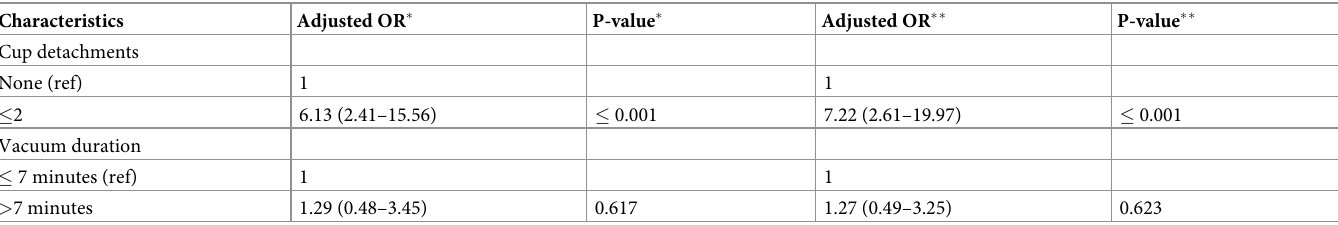
Table 3. Multivariable linear regression analysis for attempted midpelvic vacuum extractions (n = 319) with odds ratio indicating the risk of failure. Characteristics